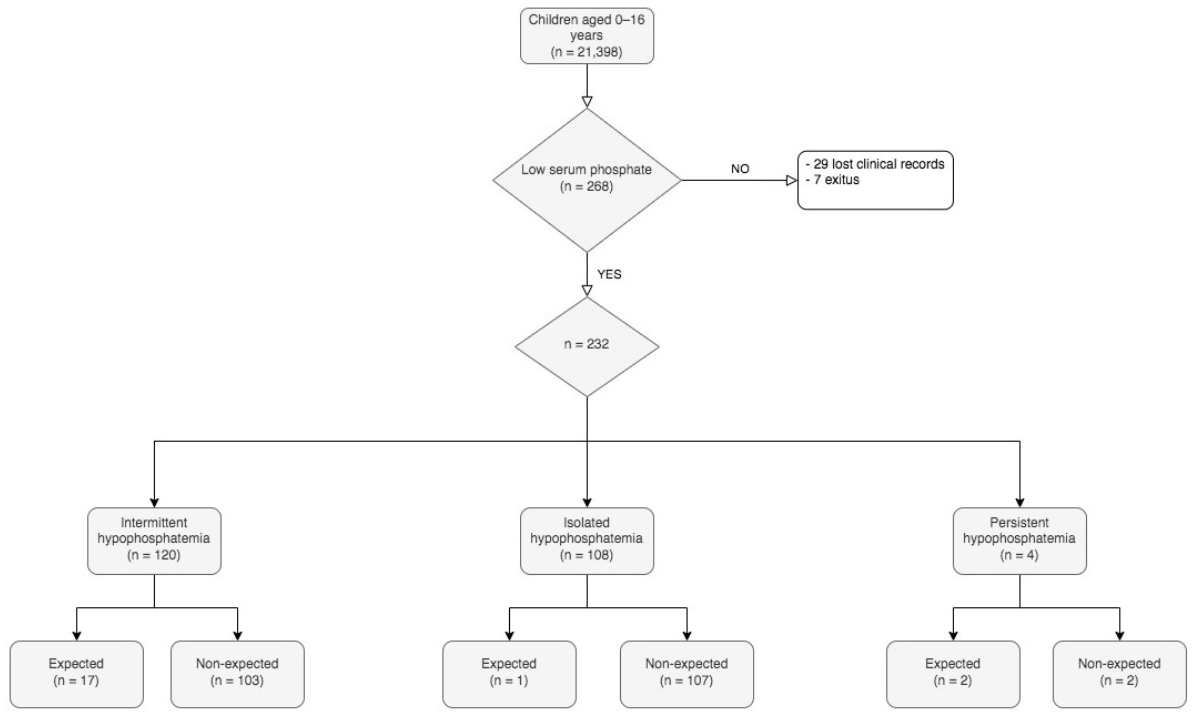
Figure 2. Distribution of cases across subgroups according to the time course and the presence or absence of a hypophosphatemia-causing disorder.